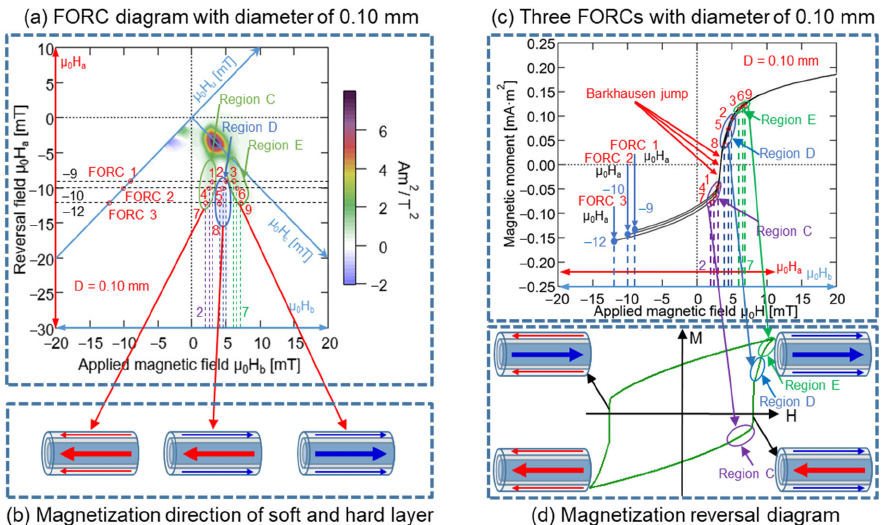
Figure 13. ( a ) FORC diagram of 0.10 mm-diameter Wiegand wire; three FORCs with varying reversal fields µ 0 H a of − 9, − 10, and − 12 mT. ( b ) Magnetization reversal direction of soft and hard layer. ( c ) Three FORCs for 0.10 mm-diameter Wiegand wire under reversal fields of − 9, − 10, and − 12 mT. ( d ) Magnetization reversal diagram of minor loop.